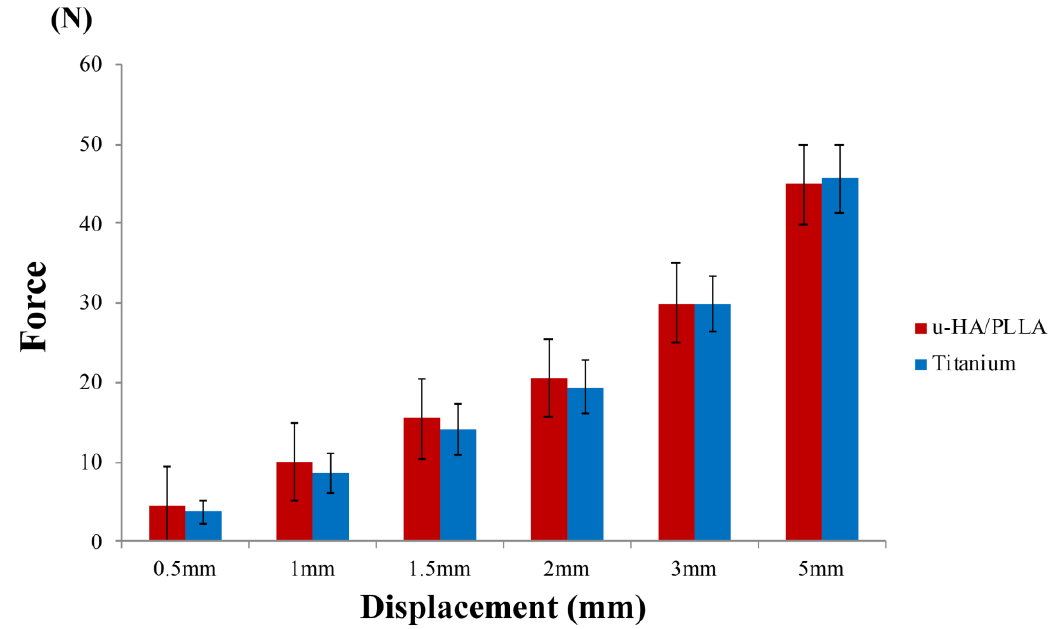
Figure 6. Load values of the titanium and unsintered hydroxyapatite (u-HA)/poly- L -lactide (PLLA) bioresorbable plates according to the amount of displacement in the lateromedial loading test.